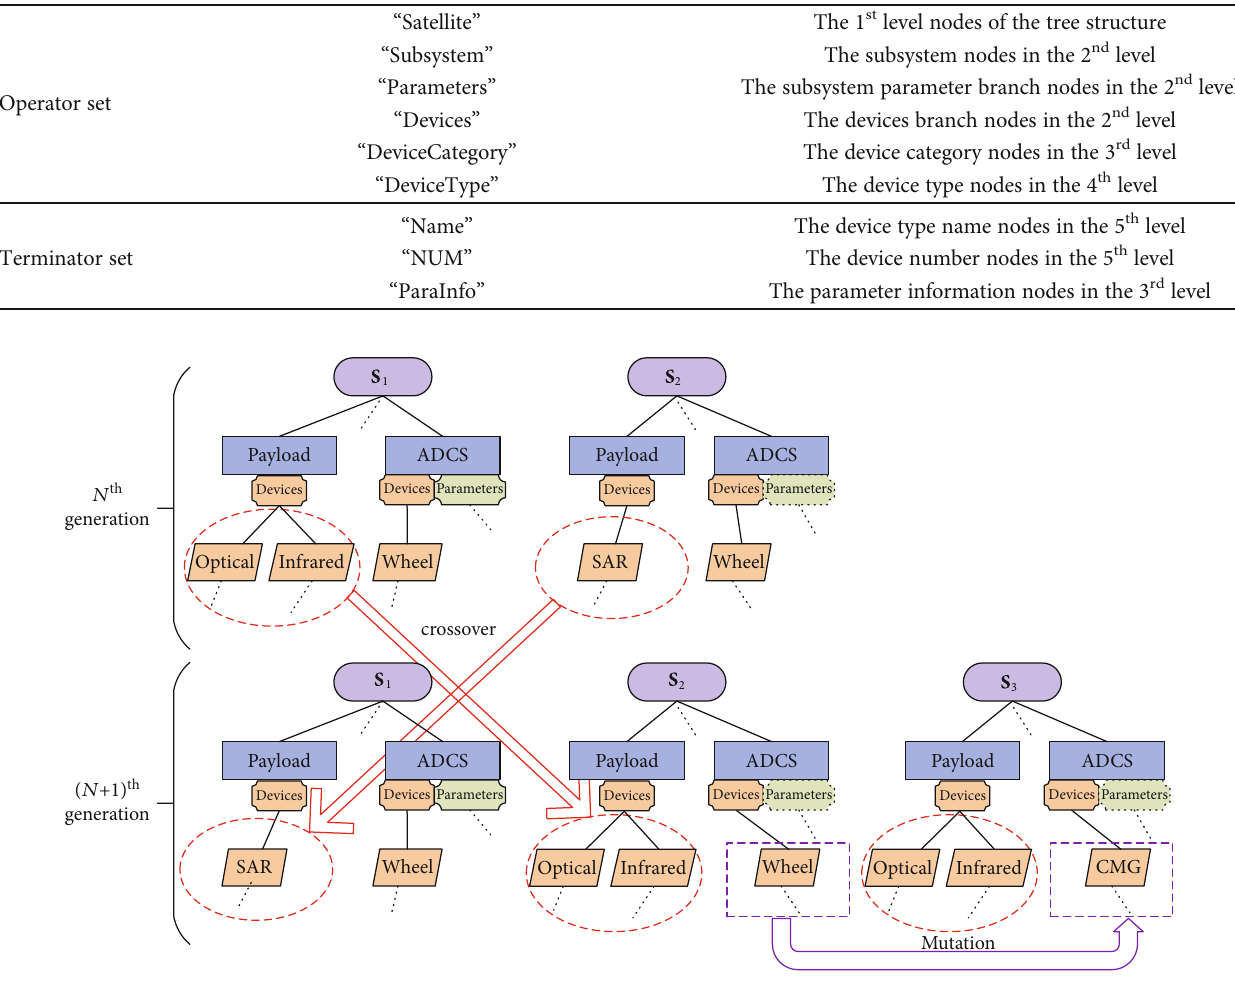
Figure 3: Schematic diagram of satellite scheme crossover and mutation operation.